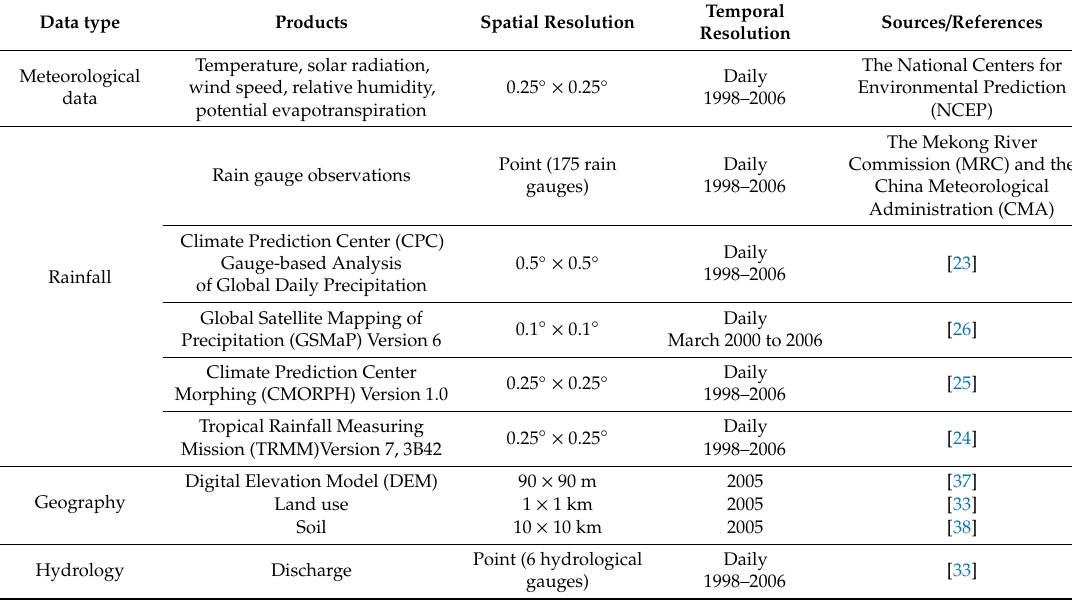
Table 1. The information datasets used in this